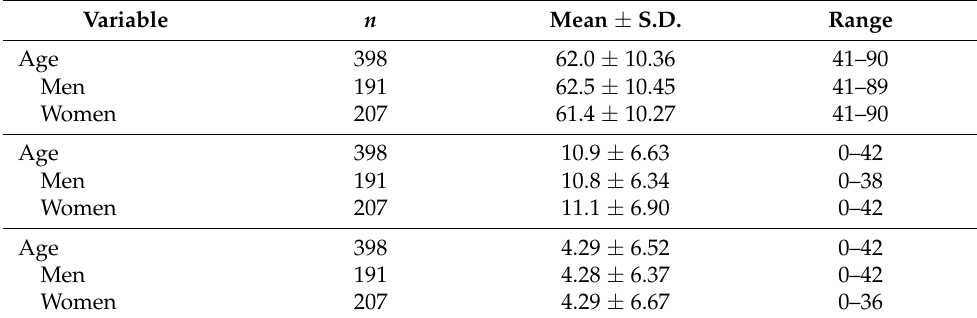
Table 1. Age and depressive degrees of participants ( n =